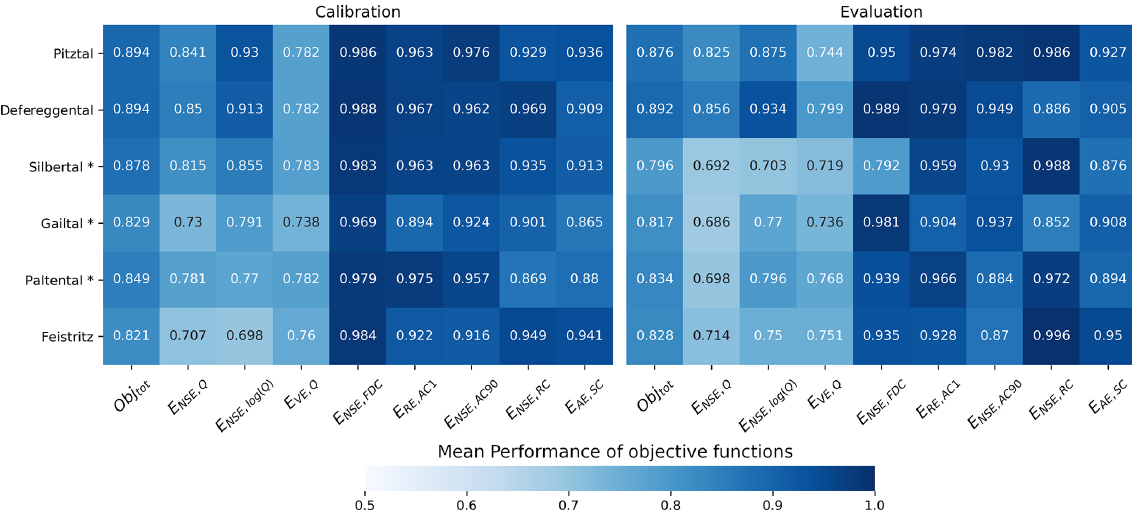
Figure 3. Mean model performance of the best 300 parameter sets for the calibration and evaluation periods. Obj tot shows the overall model fit. Table 4 gives a description of the objective functions. The asterisk ( ∗ ) indicates the catchments that use 8 years of evaluation instead of 10.